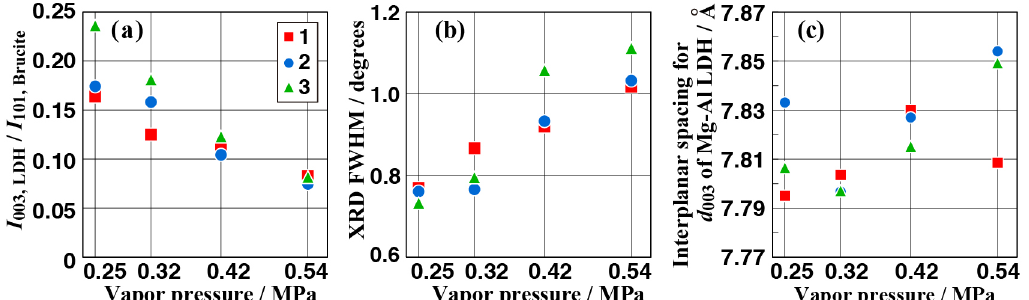
Figure 8. Analysis results based on GAXRD data: the relationship between vapor pressure and the intensity ratio of the 003 reflection peak of Mg-Al LDH to the 110 reflection peak of Mg(OH) 2 ( a ), XRD FWHM values for intensity peak of the 003 reflection ( b ), and inter-planar spacing for the [003] plane of Mg-Al LDH ( c ).